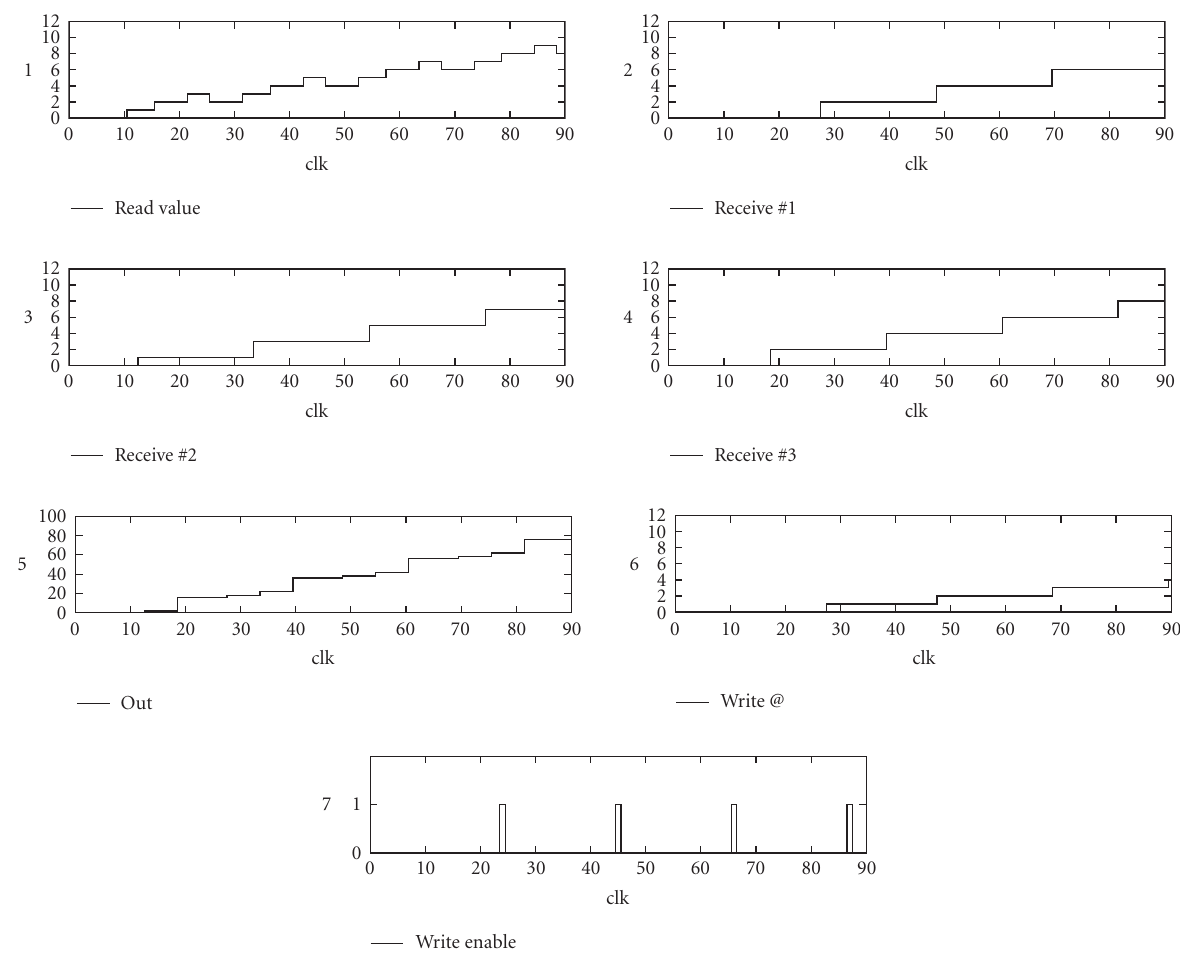
Figure 13: Internal view of a low-level